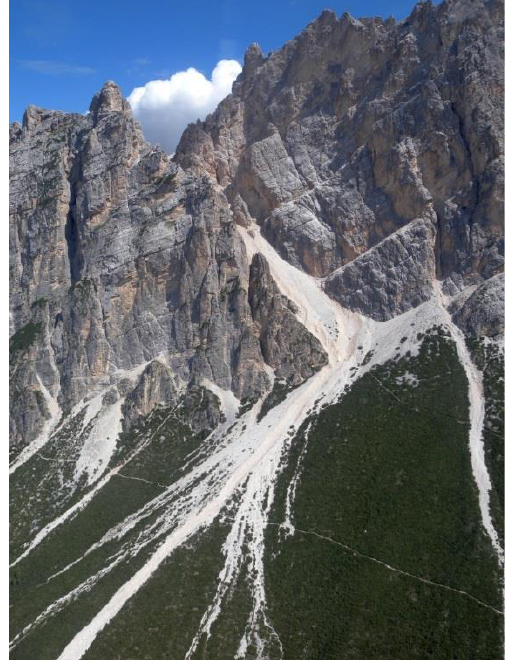
Figure 1. Dolomite massif with incised debris flow channel at study area in northeastern Italy.